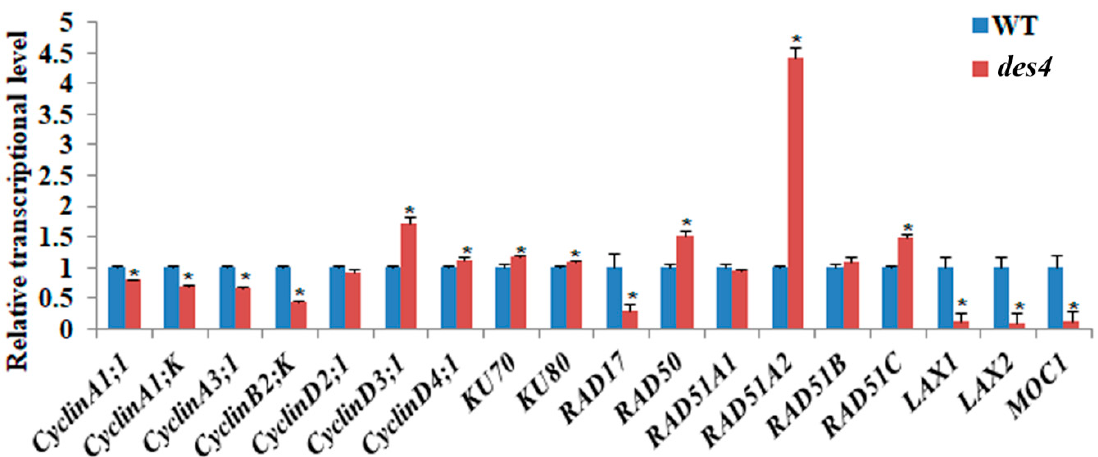
Figure 5. qRT-PCR analysis of double-strand break (DSB) repair genes and spikelet number genes. qRT-PCR analysis of transcript levels of DSB repair genes and spikelet number genes in WT and des4 . Rice actin ( LOC_Os03g61970 ) was used as an internal control. The locus ID for each gene can be found in Table S1. Values are means ± SE. Asterisks indicate significant differences between WT and des4 (* p < 0.05; Student’s t -test).